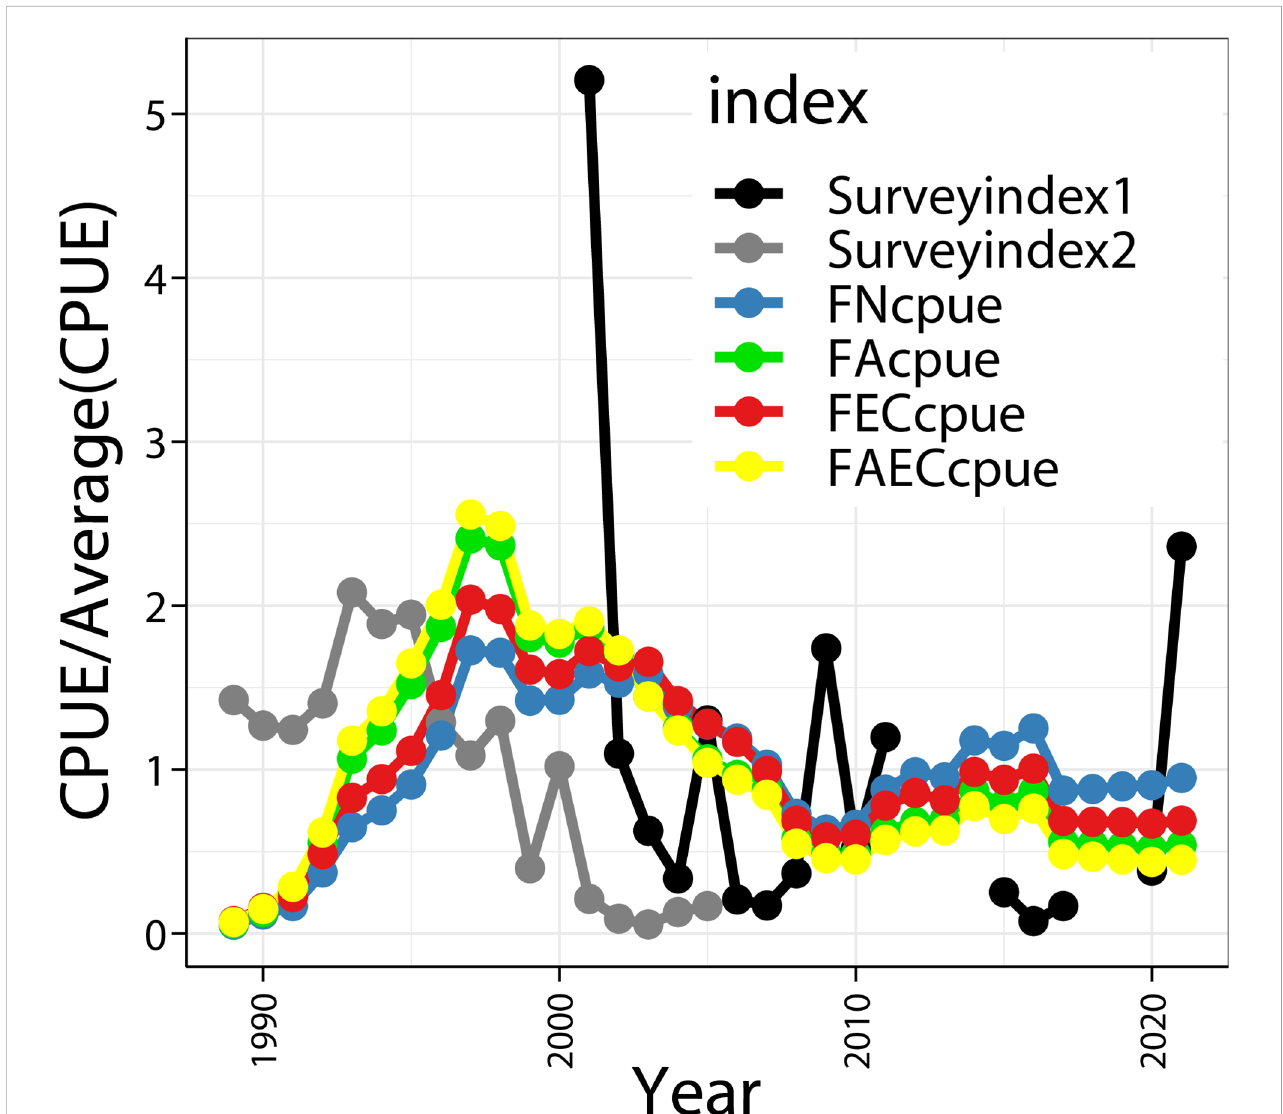
FIGURE 3 Comparison of trends in two scienti fi c survey biomass indexes and four forms of fi shery CPUE. The trend values here are provided in the form of CPUE/ Average(CPUE). Surveyindex1 was obtained from the 2001-2021 trawl survey. surveyindex2 was obtained from the 1989-2005 acoustic survey. FNcpue is the nominal commercial fi shery CPUE. FAcpue is the commercial fi shery CPUE accounting for average power per vessel. FECcpue is the commercial fi shery CPUE accounting for effort-creep. FAECcpue is combination of both FAcpue and